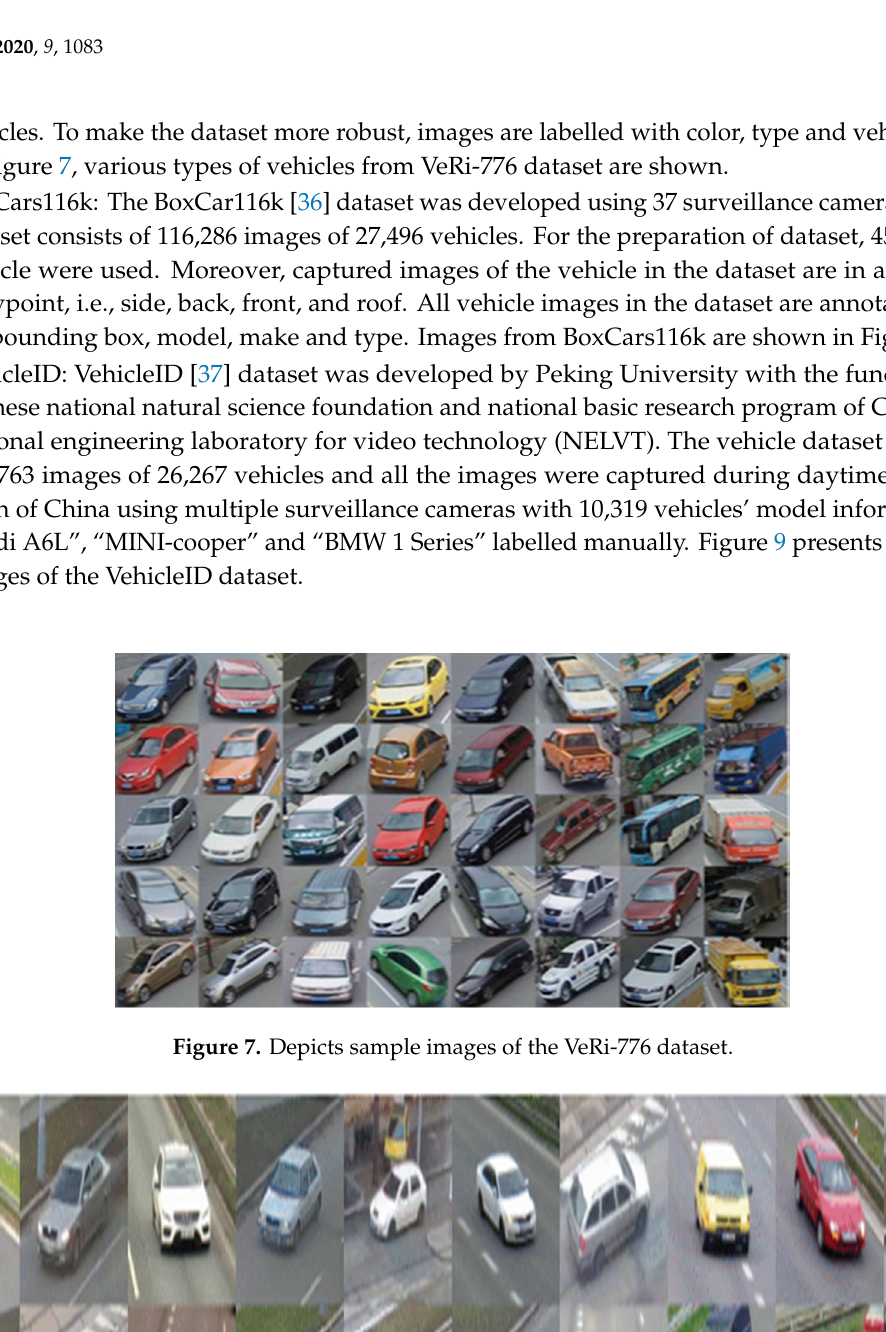
Figure 9. Depicts sample images of the VehicleID dataset.